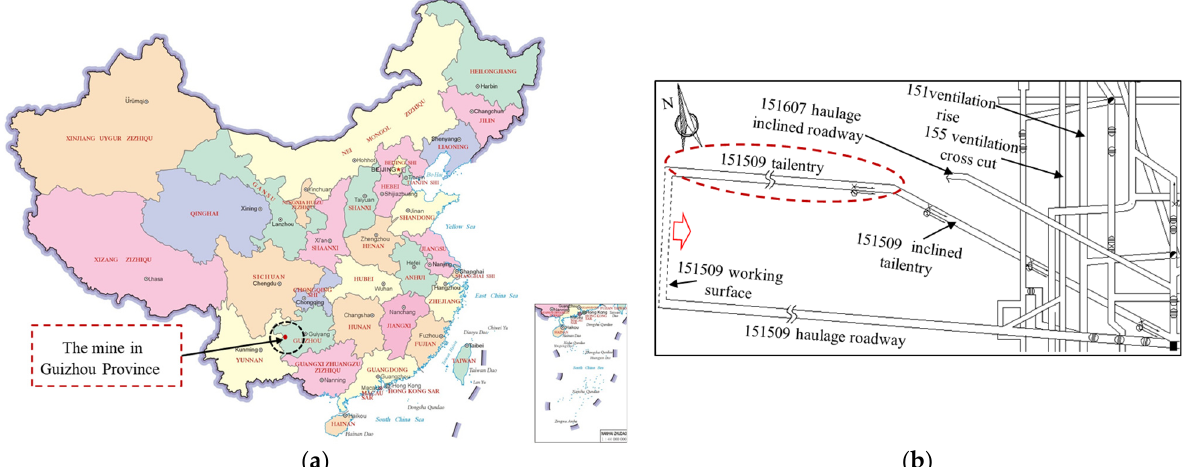
Figure 1. ( a ) Location of the coal mine, Guizhou, China. ( b ) Plan view of the main roadway in the shaft bottom of the coal mine in Guizhou Province.